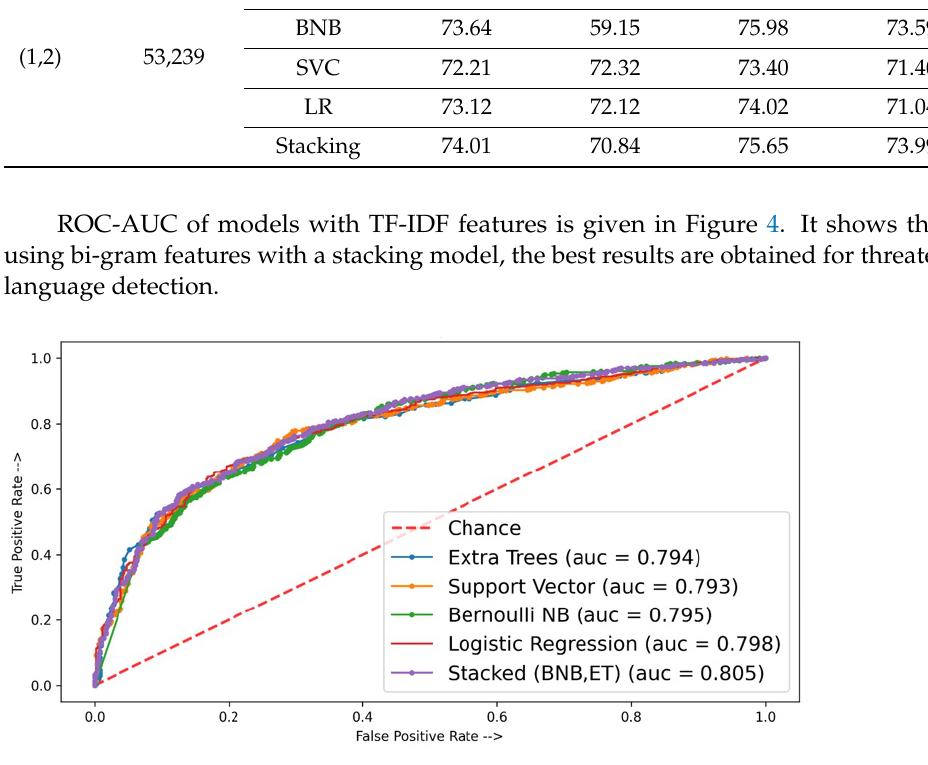
Figure 4. ROC using TF-IDF